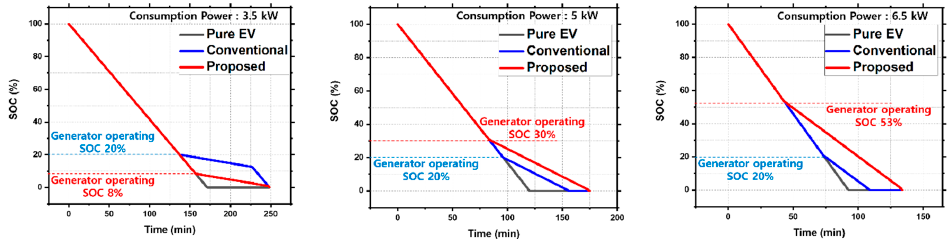
Figure 2. Varying generator operating point based on user power consumption.